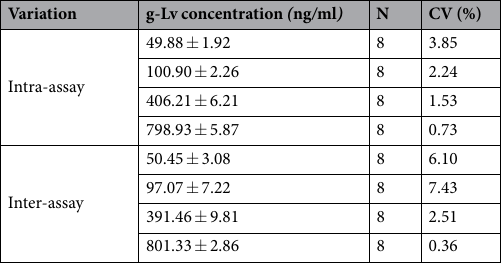
Table 1. Precision tests of the sandwich ELISA. Values of Lv concentration are expressed as mean ± standard deviation; N is the number of determinations; and CV is the coefficient of